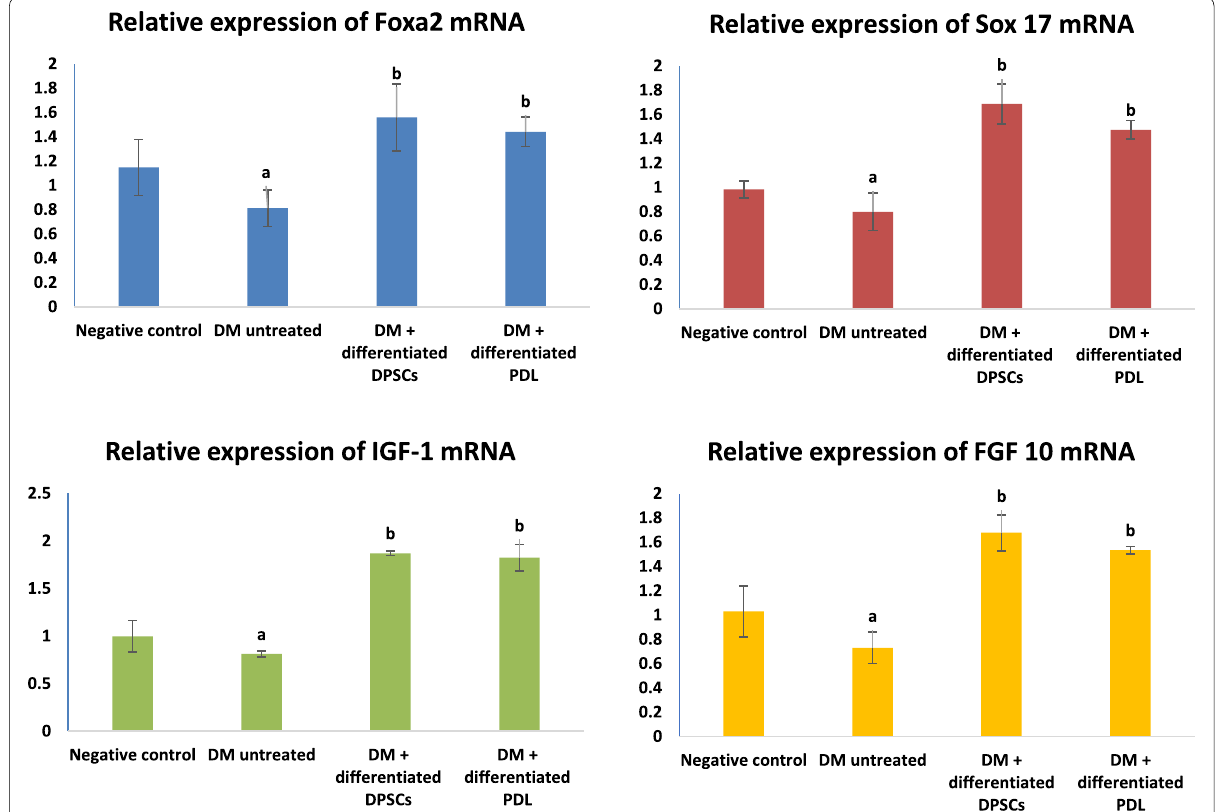
Fig. 9 Effect of transplanted IPCs on the expression level of (i) Foxa2, (ii) Sox 17, (iii) IGF‑1, and (iv) FGF 10 genes in diabetic rats. Data are expressed as means SD of 8 rats/group. Significant change at P > 0.05 denoted by ( a ) in comparison with the negative control group. Significant change at ± P > 0.05 in comparison with the untreated DM